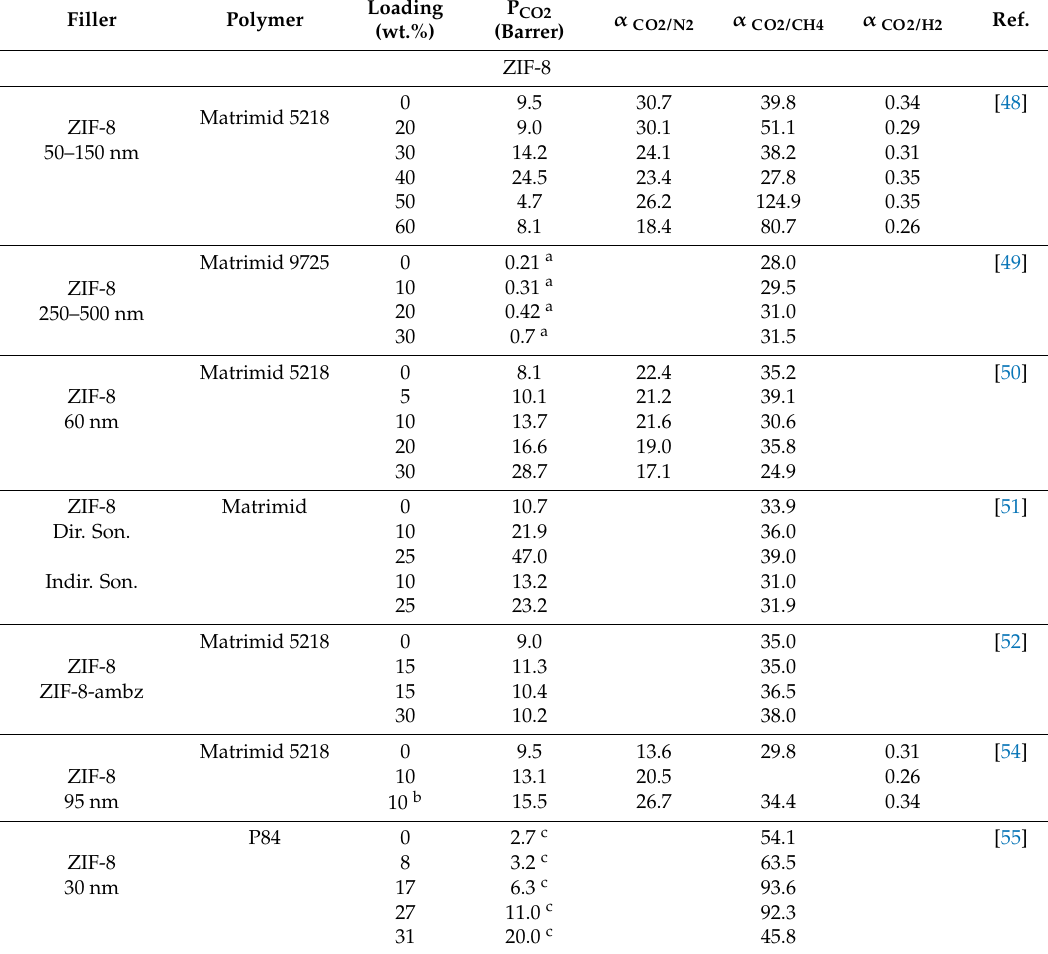
Table 1. Gas separation performance of ZIFs-b ased mixed matrix membranes (operating conditions ranging within 1–5 bar, 20–35 ◦ C, unless differently